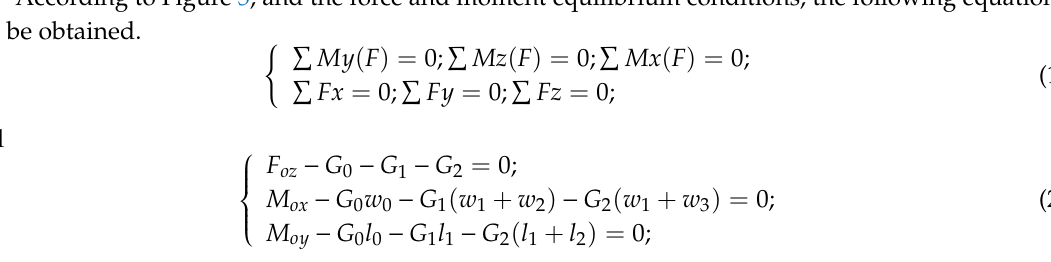
Figure 5. Schematic figure of the constraints and loads imposed on the upper arm.